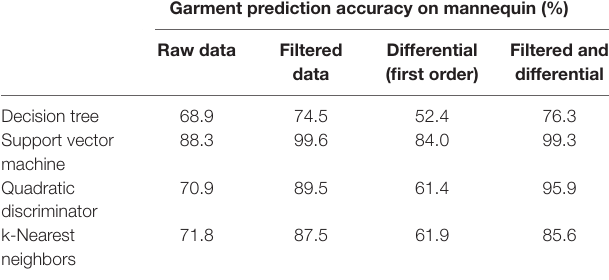
TaBle 2 | Prediction of base layer accuracy (no garment, shirt, t-shirt, and jumper) based on mannequin dressing tests (pose 1) using all sensor data (18